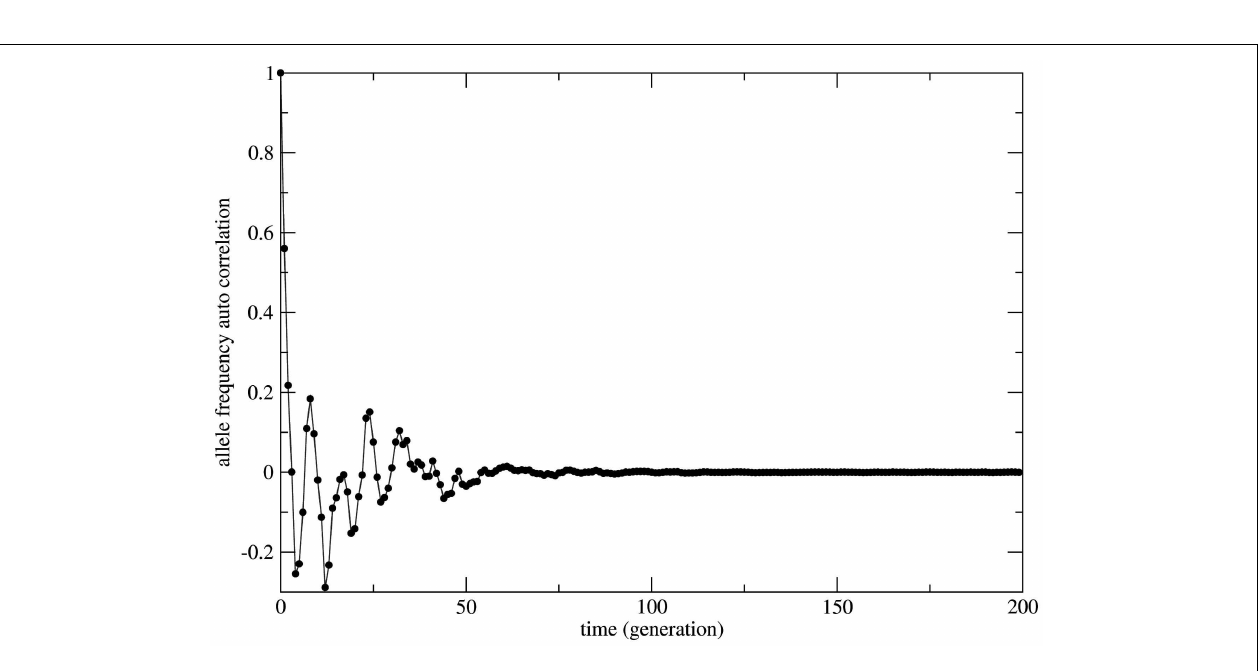
grows till a population size of 3.0 × 10 7 individuals.The simulation total time is 3.0 × 10 5 generations. After approximately 100 generations the correlation function is very close to zero indicating that (stable) equilibrium has been